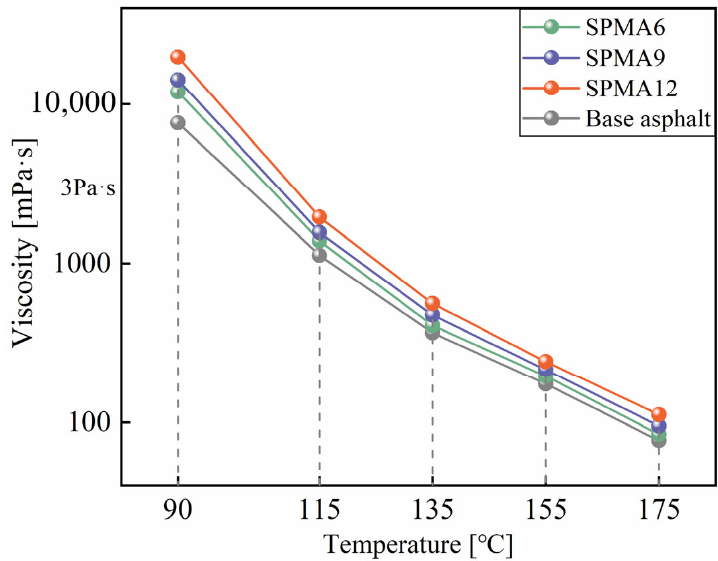
Figure 6. Apparent viscosity of asphalt binders.